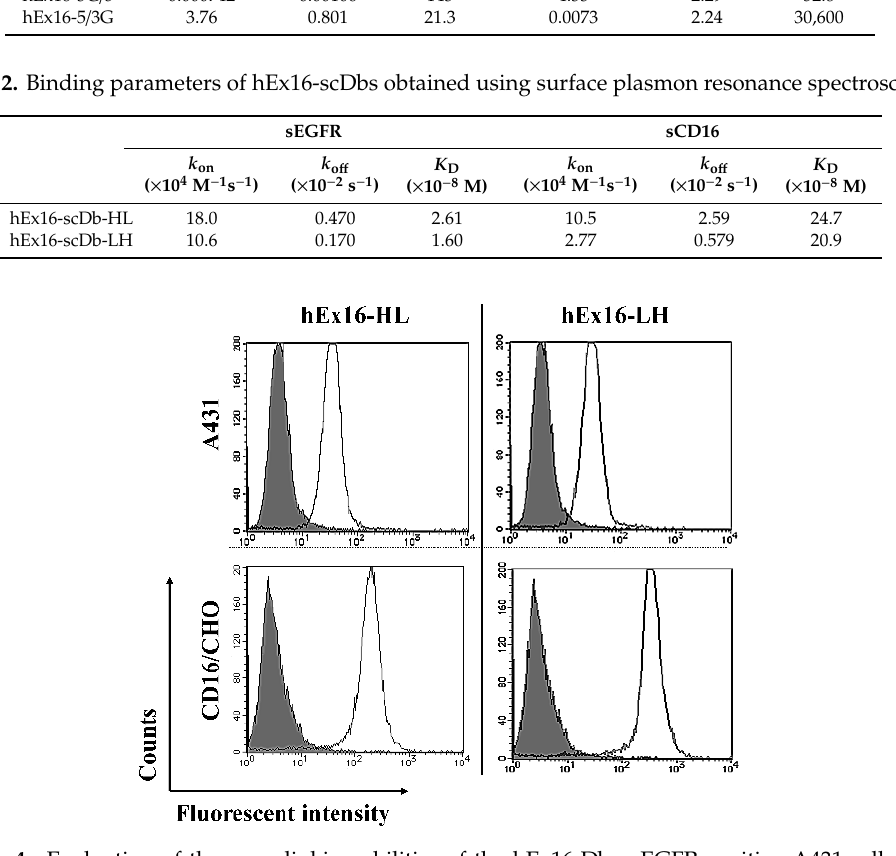
Figure 4. Evaluation of the cross-linking abilities of the hEx16-Dbs. EGFR-positive A431 cells and CD16/CHO cells were incubated with PBS, as a negative control (shaded area), or with each hEx16-Db (open area), followed by staining with fluorescein isothiocyanate (FITC)-sCD16 for A431 cells (upper panels) or with FITC-sEGFR for CD16/CHO cells (lower panels).